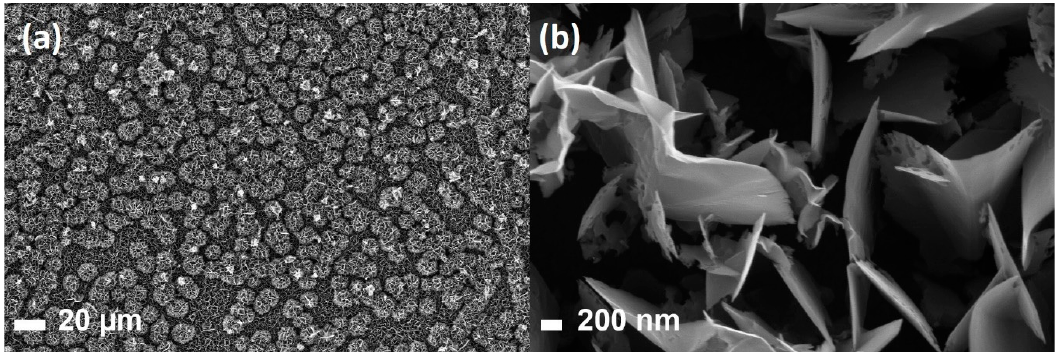
Figure 2. SEM images of graphene nanowalls; ( b ) the enlarged image of the area of “bushes” made of graphene sheets in ( a ).